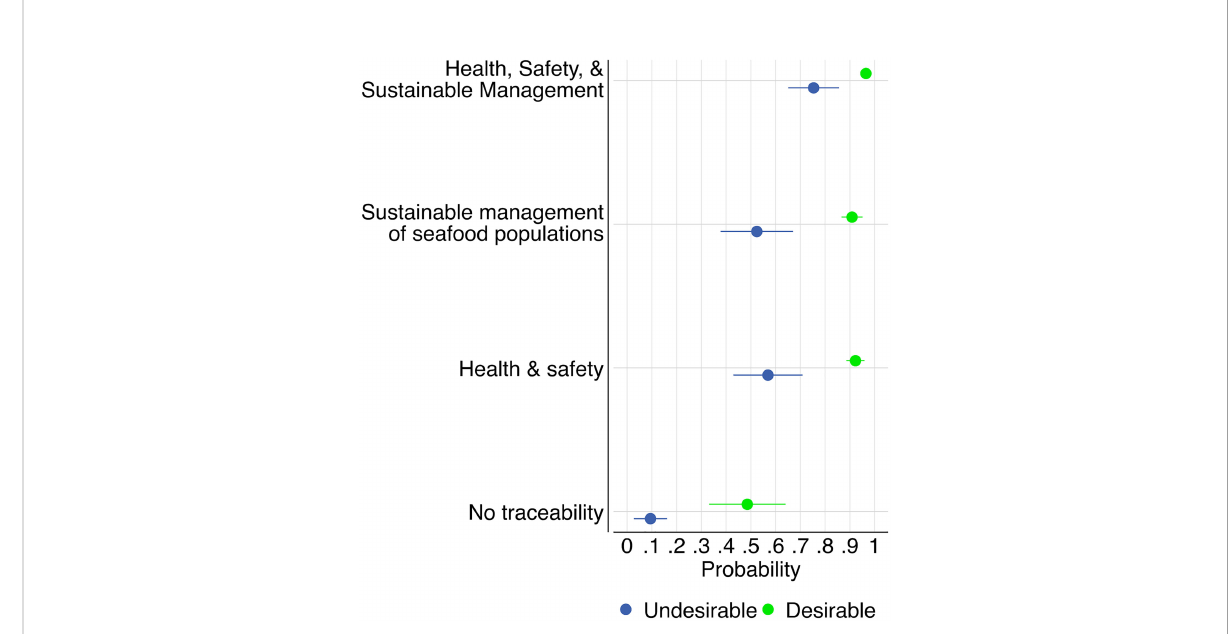
FIGURE 3 Predicted probability (and 95% con fi dence intervals) of restaurateur participation in voluntary traceability programs. The most undesirable program was one with a 30% increase in price, 65% reliability, and usual quality. The most desirable program was one with the current price, 95% reliability, and premium quality. Three control variables were included in the model to control for cost of dining and the diversity of seafood products available at a restaurant (see Table